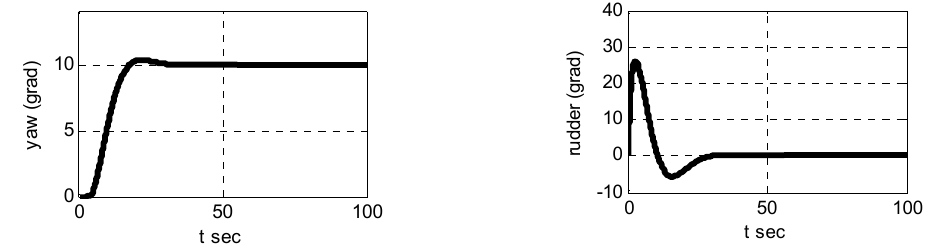
Figure 6. Graphs of the functions y ( t ) and δ ( t ) for real closed-loop system (23), (30), (31) in Regime 1 of motion.